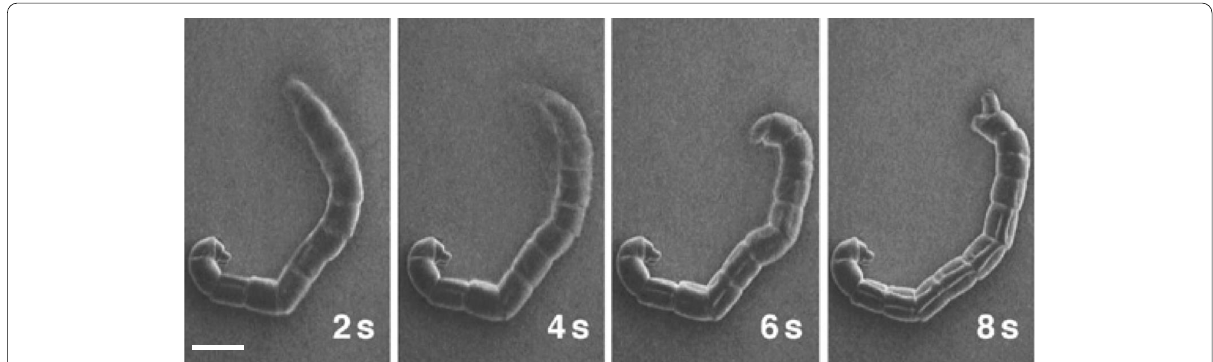
Fig. 7 Sequential scanning electron micrographs of the larva of the midge Chironomus yoshimatsui . The larva was immersed in 1 % Tween 20